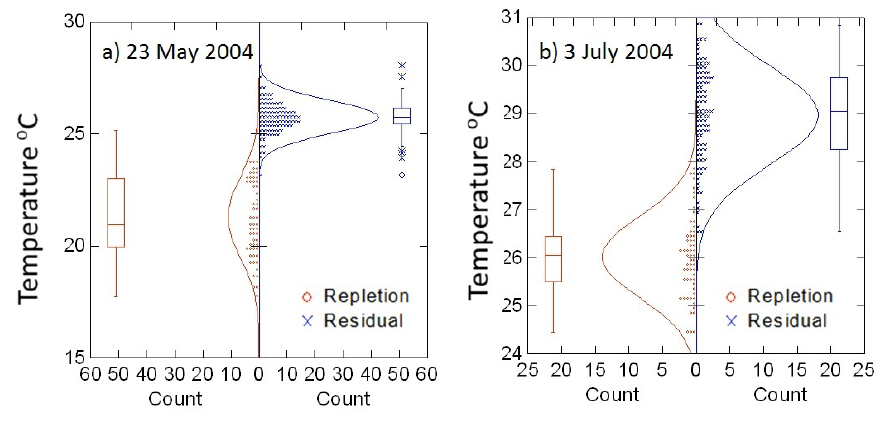
Figure 8. Frequency distributions and boxplots of derived ASTER skin surface flood tide repletion and residual lagoon water mass temperatures for sampled pixels ( a ) May and ( b ) July 2004